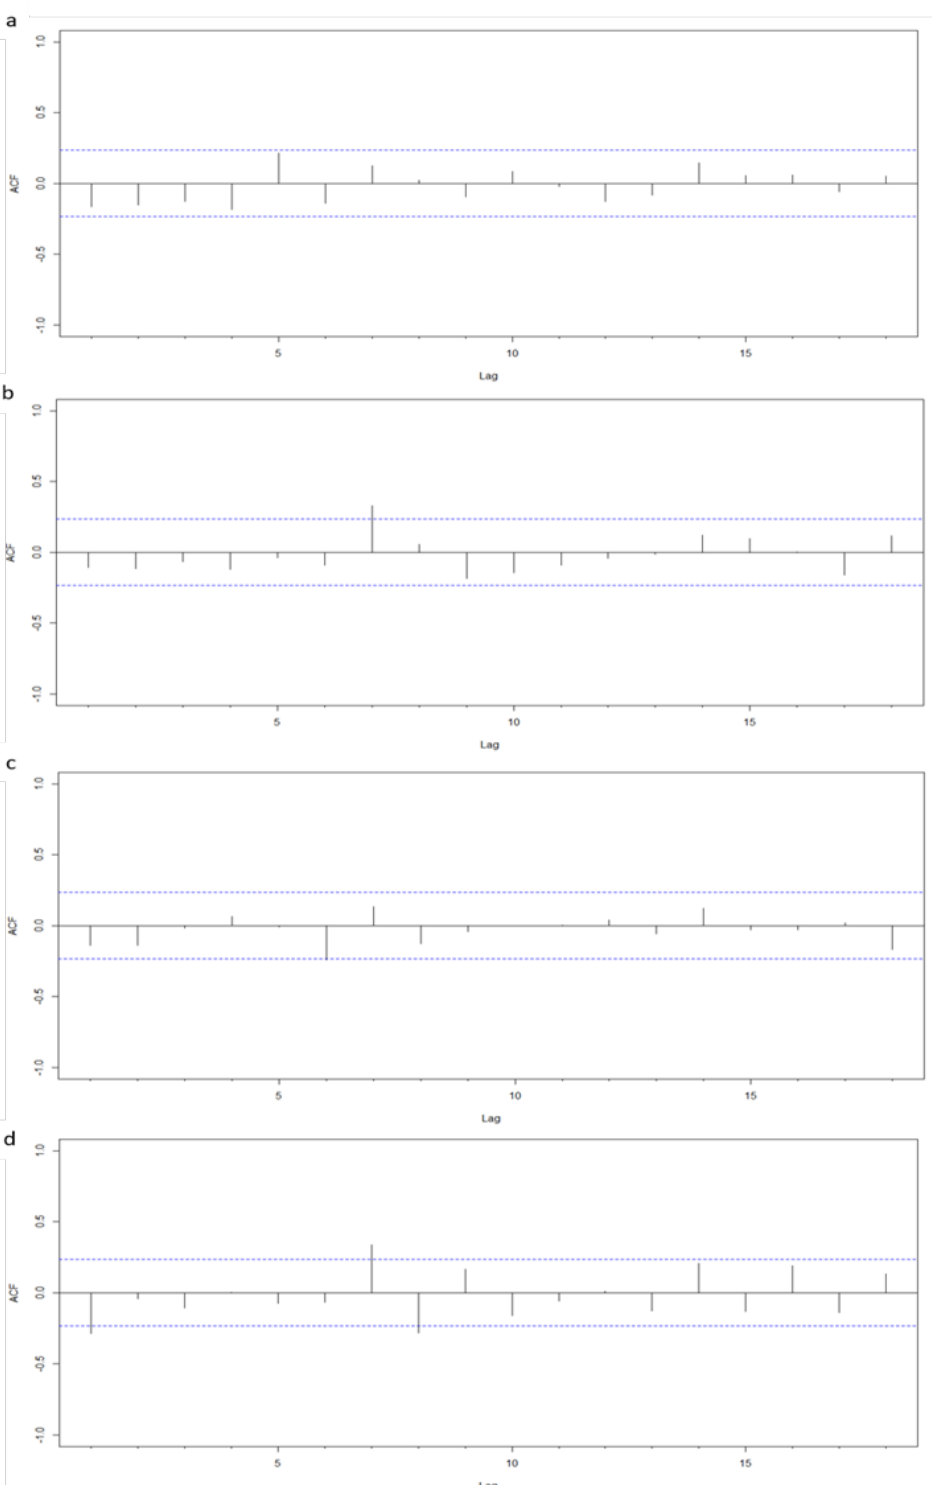
Figure A2. Autocorrelation plots of the residuals of the GAM models adjusted to the production (peak NDVI) of the four main vegetation types consumed by wild and domestic ungulates at the study area (Doñana National Park). Model for saltmarsh ( a ), bulrush marsh ( b ), shrubland ( c ), and grassland ( d ).